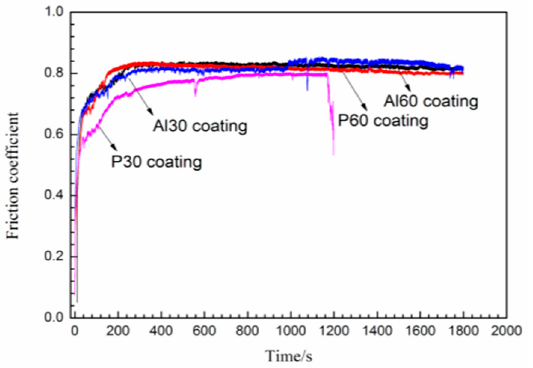
Figure 7. Friction coefficient as a function of sliding time under 5 N for P30, Al30, P60, and Al60 coating.